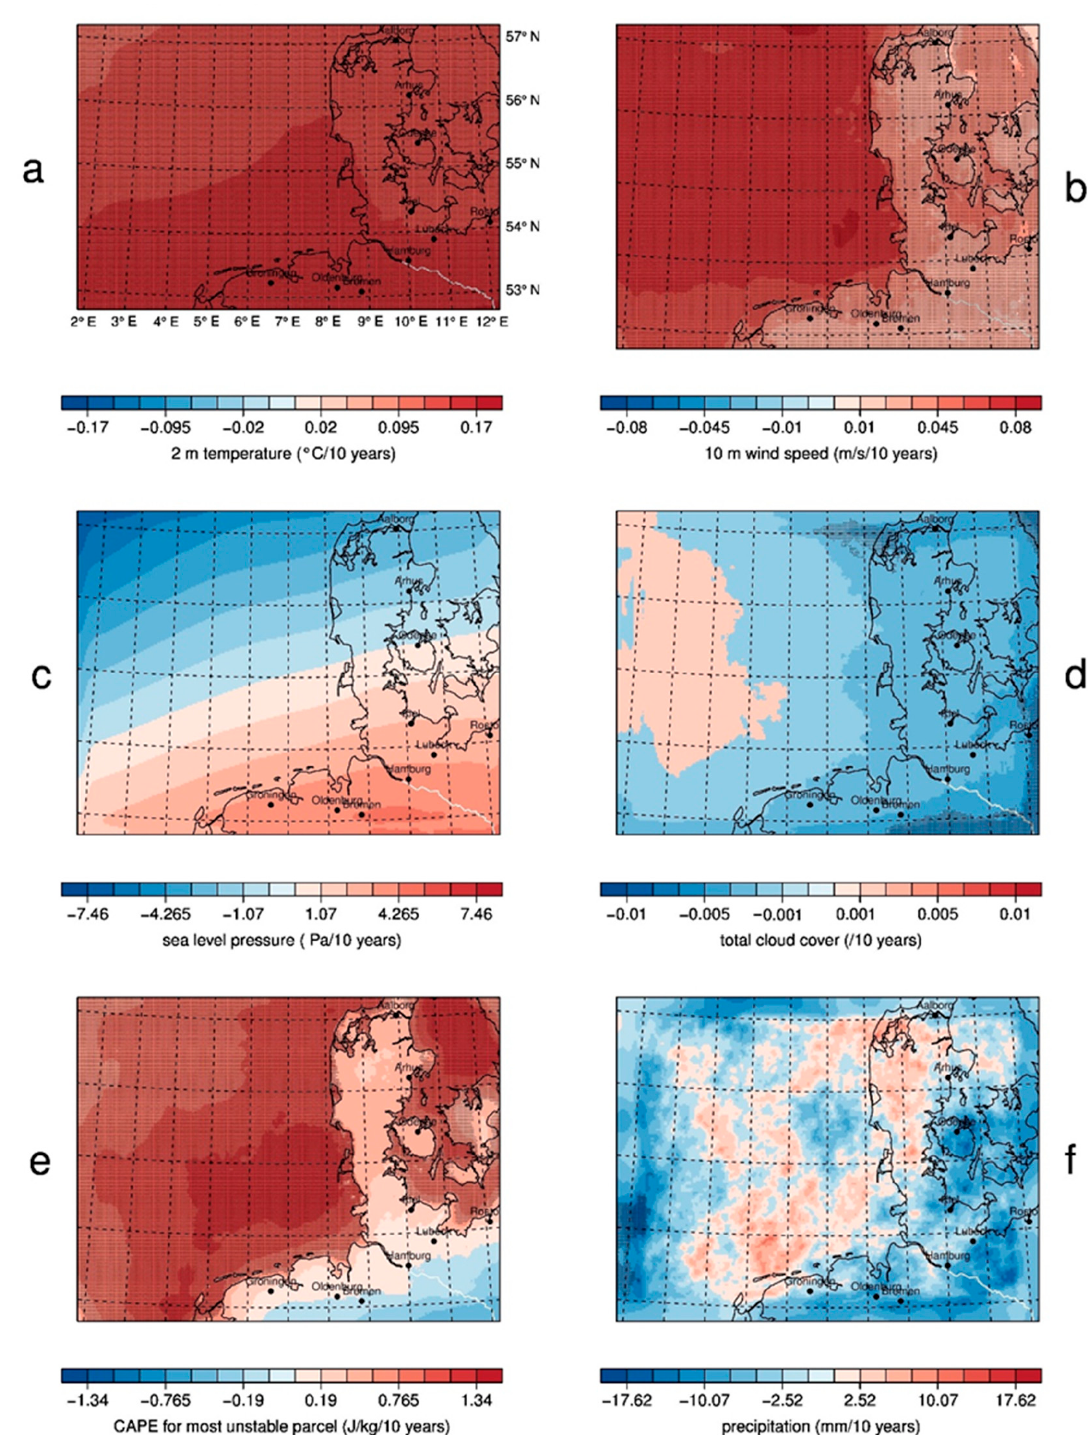
Figure 3. GB0028 decadal trend over 67 years of ( a ) annual mean 2 m temperature, ( b ) annual mean 10 m wind speed, ( c ) annual mean sea level pressure, ( d ) annual mean total cloud cover, ( e ) annual mean CAPE, ( f ) annual sum of precipitation. Shaded areas indicate a statistical significance at the nominal 5% level.